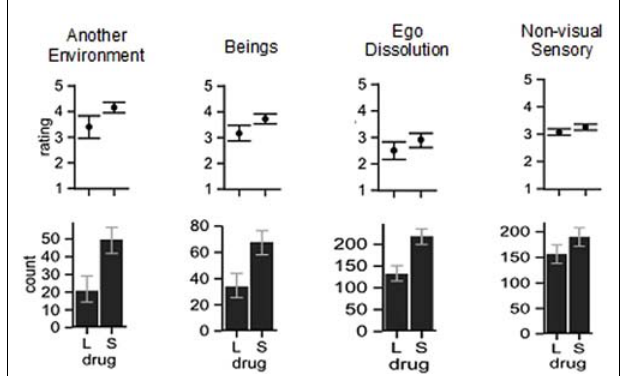
FIGURE 2 | Comparison of the average rating (top row) and number of trip questions that received ratings (bottom row) for S. divinorum and LSD trip reports. See trip report analysis deposited at http://dx.doi.org/ 10.6084/m9.figshare.902215 for associated statistics. Error bars are 95% confidence intervals. For the counts, the confidence intervals were calculated with Agresti and Caffo’s (2000) add-4 method and for the mean ratings, they were